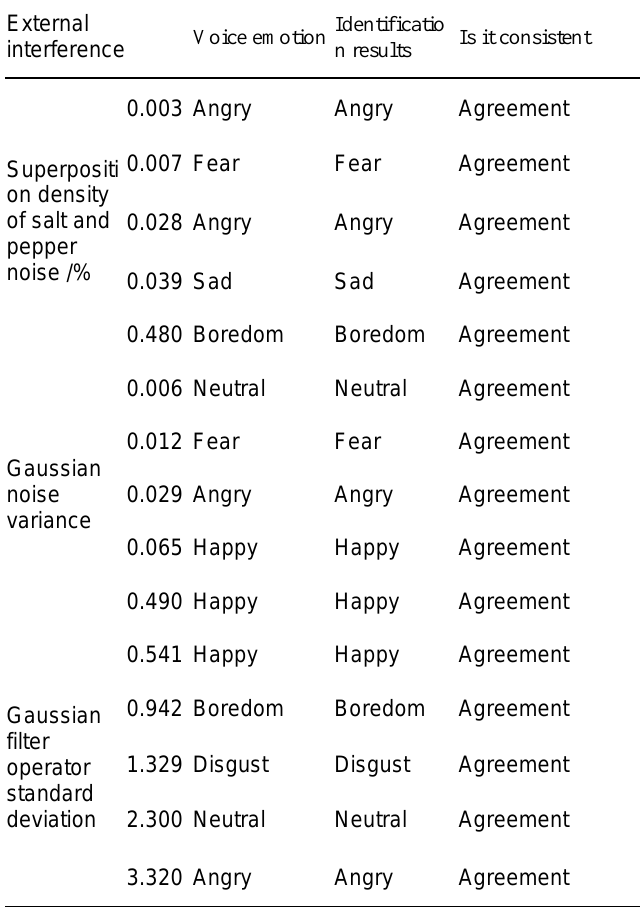
Table 1 . Identification results under different interference